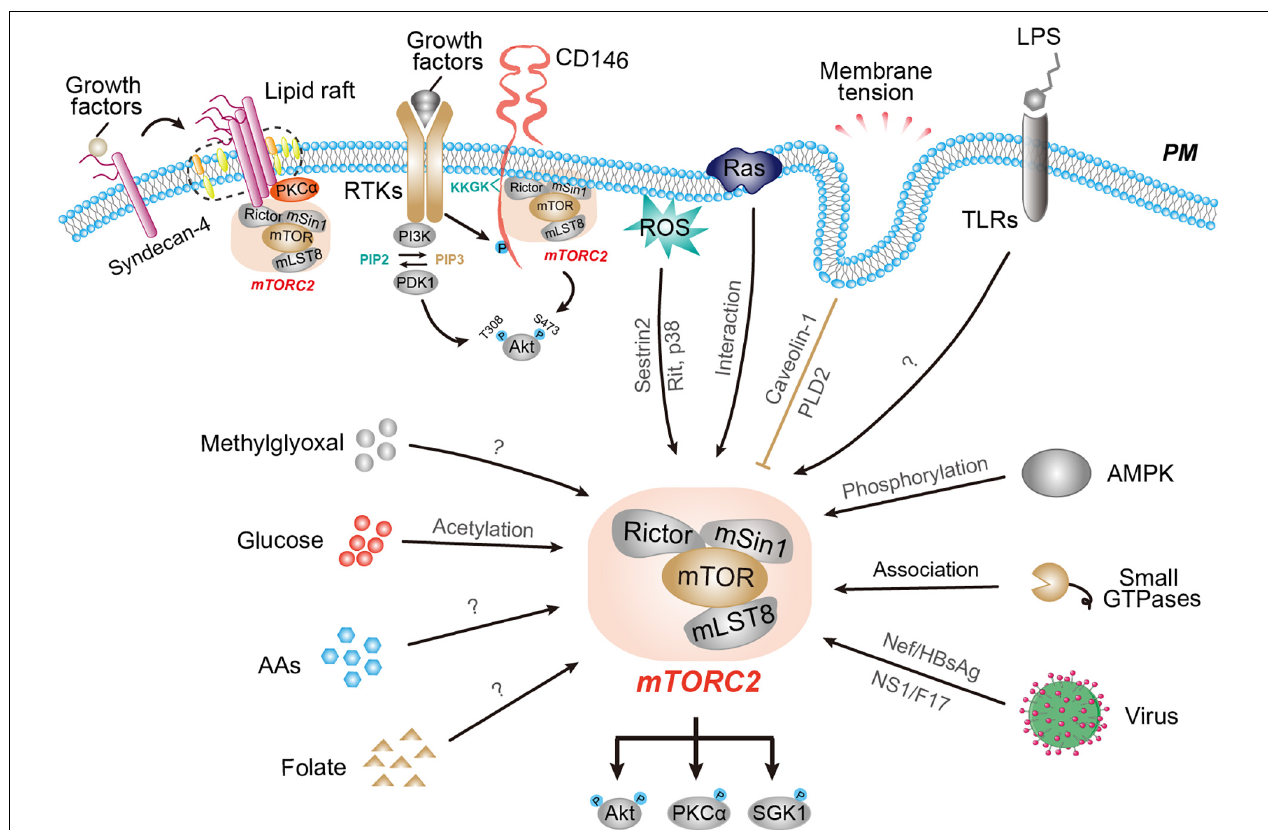
FIGURE 1 | The responses of mTORC2 activity to various environmental and intracellular cues. Schematic representation of mTORC2 activity in response to a wide array of upstream regulators, including signals from the plasma membrane, metabolites, and pathogens as well as intracellular cues. Interference with membrane tension activates mTORC2 through caveolin-1 and PLD2. RTK signaling activates mTORC2 via PI3K-dependent and -independent mechanisms. Oncogenic Ras and CD146 associate with and activate mTORC2 at the plasma membrane. The activity of mTORC2 is regulated by nutrients, such as glucose, amino acids, and folate. Several intracellular cues, such as AMPK, small GTPases, ribosomes, and ROS also regulate mTORC2 activity through distinct